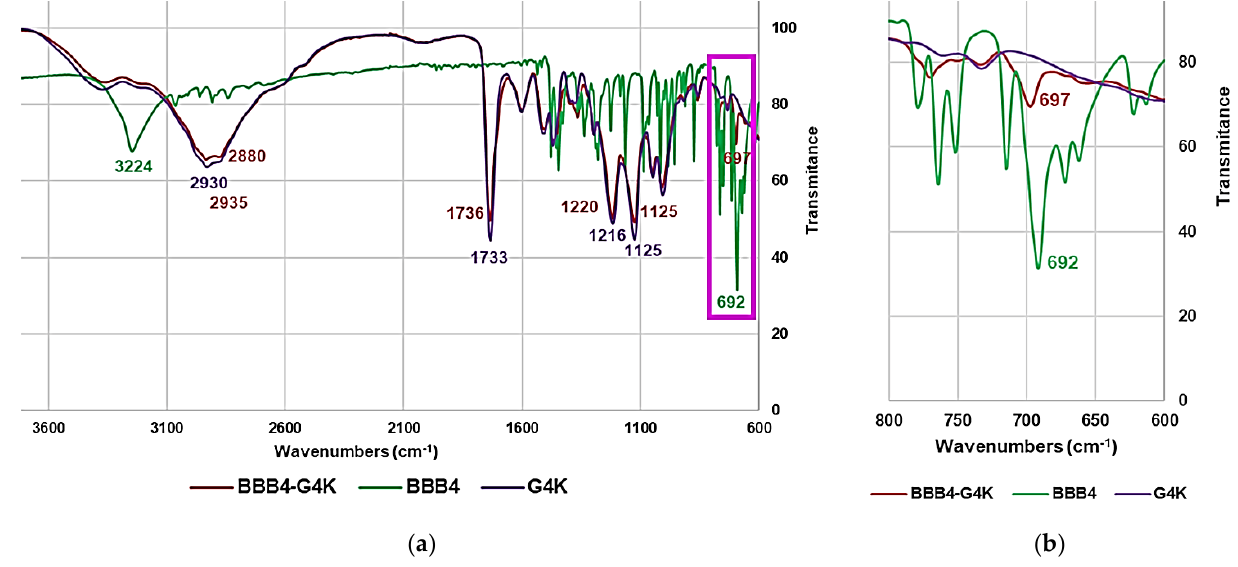
Figure 4. ATR-FTIR spectra of G4K (purple line), BBB4 (green line), and BBB4-G4K (dark red line) ( a ); magnification of a significant spectral region ( b ).